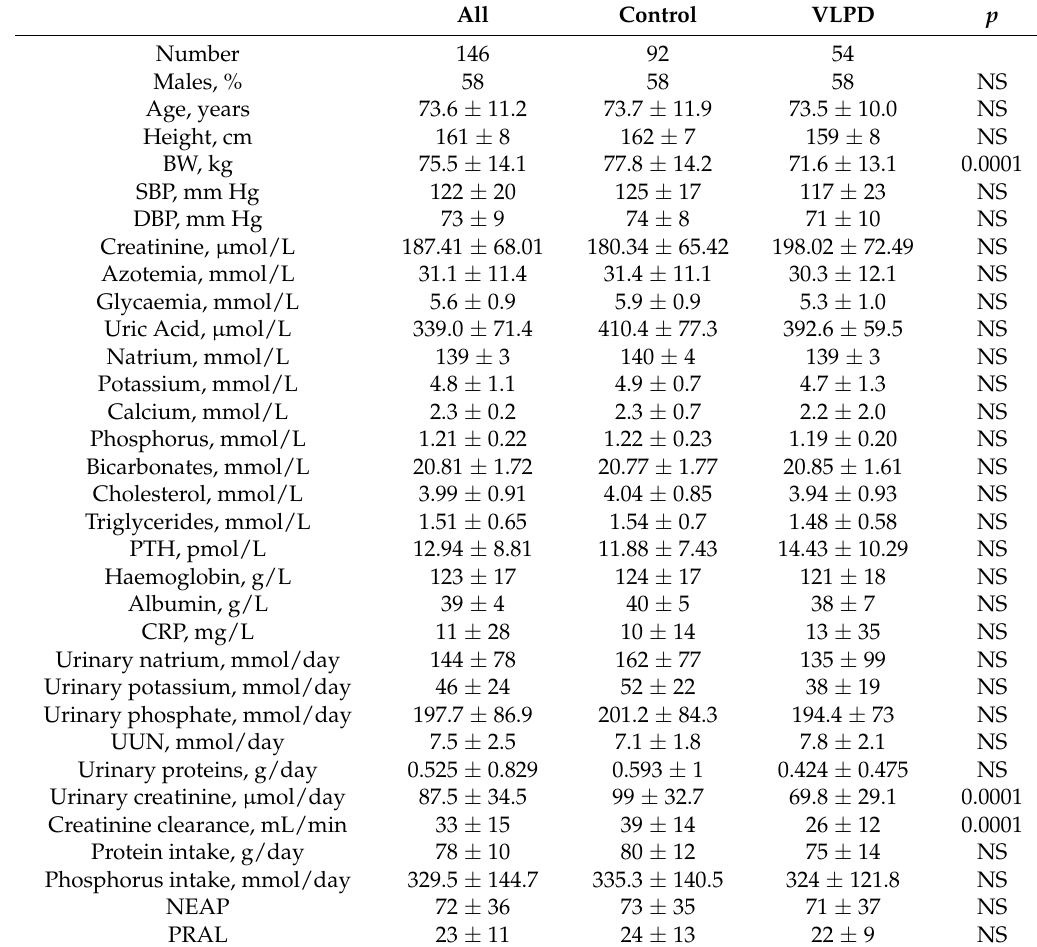
Table 2. Patients’ baseline